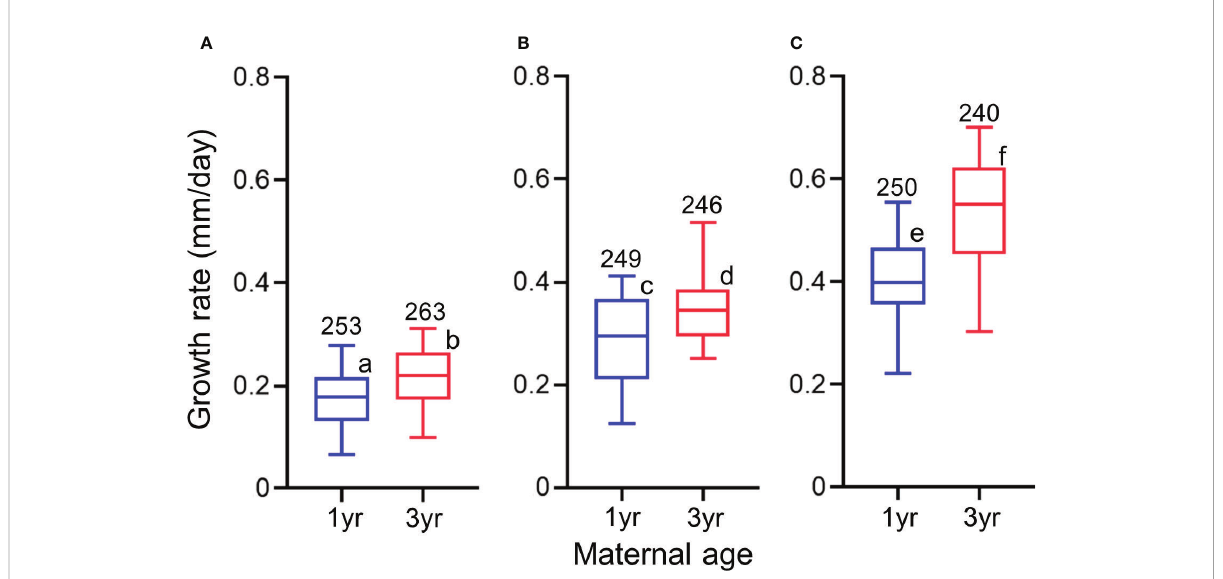
FIGURE 7 Effect of maternal age (1 or 3 years) on the growth rate of 10-day-old chub mackerel in different temperature treatments: (A) = low temperature (16.6°C), (B) = medium temperature (20.6°C), and (C) = high temperature (22.3°C). The whiskers represent 5th and 95th percentiles of the